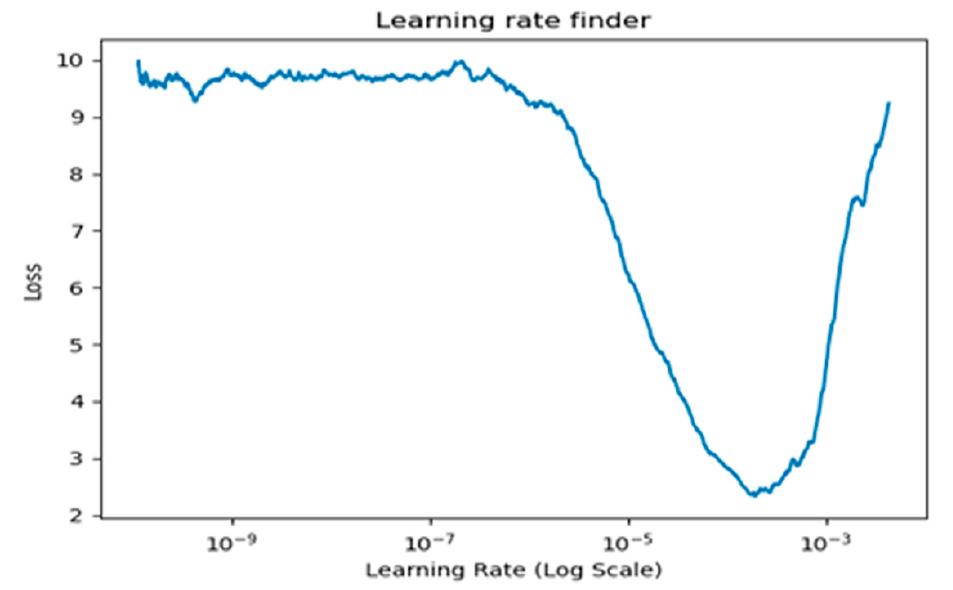
Figure 20. Minimum and maximum bound learning rate values.